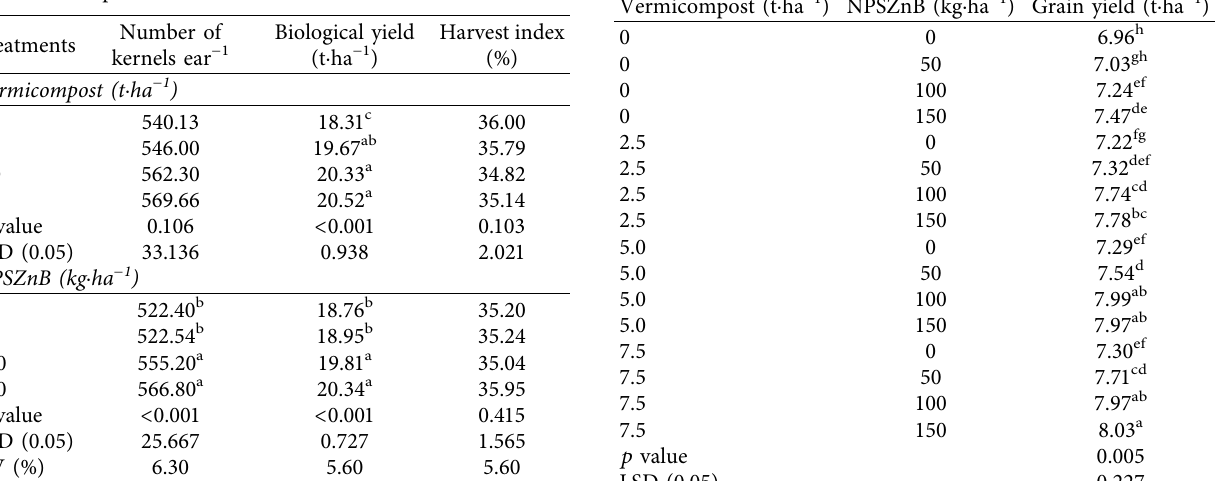
Table 6: Main efects of vermicompost levels and inorganic NPSZnB fertilizer rates on the number of kernel ear − 1 , biological yield (t · ha − 1 ), and harvest index (%) of maize in Guto Gida, Western Ethiopia.